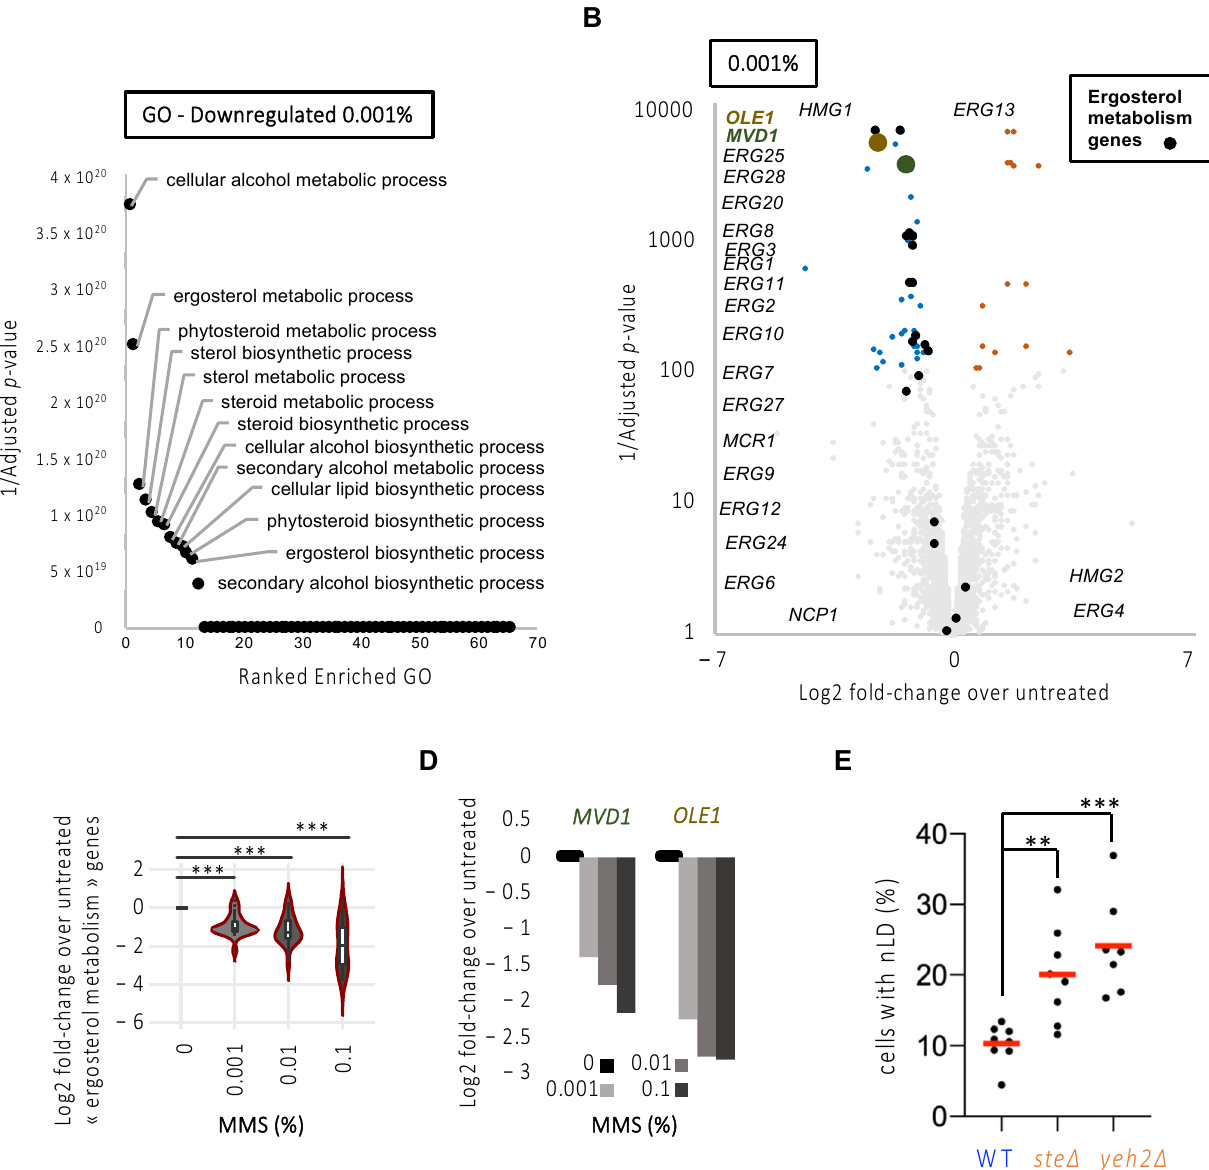
Figure 4. MMS treatment triggers a downregulation of fatty acid unsaturation and the sterol transcriptional network that is supportive of nLD formation. ( A ) Overrepresentation test of downregulated genes upon 1 h 0.001% MMS treatment. Enrichment is computed with Fisher’s test and corrected for multiple testing by false discovery rate. The 1/Adjusted p -values for all the enriched pathways are represented. The top pathways are annotated. See also Table S5. ( B ) Volcano plots of all genes in response to 1 h 0.001% MMS. Fold-changes are computed from the average RNA signal of MMS-treated samples versus the average RNA signal of untreated ones. Adjusted p -values were computed with the Limma software [9] and corrected for multiple tests. Genes with significant changes according to the adjusted p -values are depicted in color, where upregulated ones are shown in orange and downregulated ones in blue. Genes annotated as related to ergosterol metabolism are annotated and depicted in black. OLE1 and MVD1 are represented in brown and green, respectively. See also Tables S2–S4. ( C ) Violin plot for the average of the Log2 fold-change of the ergosterol-re- lated genes for 1 h treatment with the three MMS doses under study. The asterisks indicate that p < 0.001 after applying a paired Mann–Whitney-test. ( D ) Bar plot for the average of the Log2 fold- change of MVD1 and OLE1 for 1 h treatment with the three MMS doses under study. ( E ) Exponen- tially growing cells of the indicated genotypes were imaged as in Figure 1A, and the experimenter